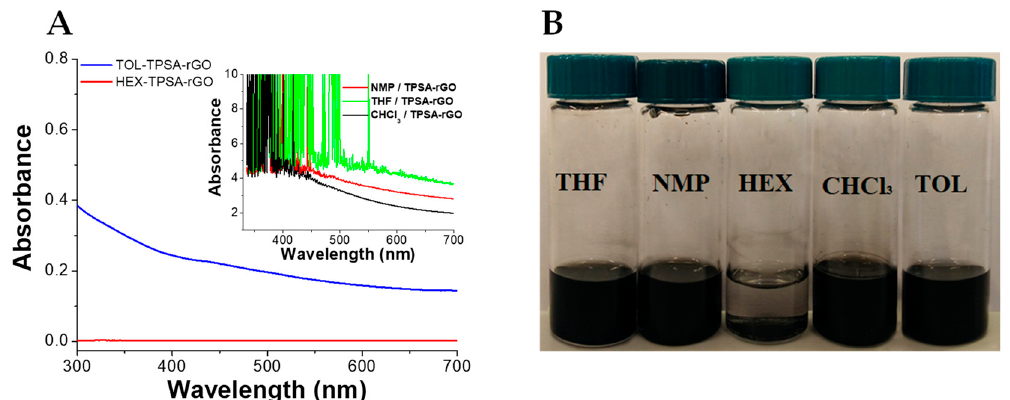
Figure 7. ( A ) UV–Vis spectra and ( B ) optical pictures of TPSA-rGO dispersed in organic solvent after preparation. Tetrahydrofuran (THF), 1-methyl-2-pyrrolidone (NMP), hexane (HEX), chloroform (CHCl 3 ), and toluene (TOL). For all dispersions, 5 mg of TPSA-rGO in 10 mL of solvent.